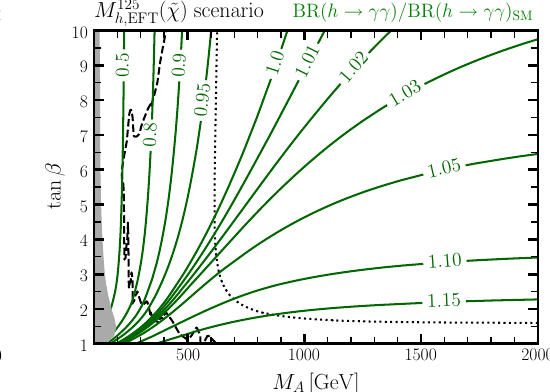
tour lines ). In each plot, the gray exclusion region and the boundaries ( ˜ χ) sce- of the blue and the hatched exclusion regions (shown as dashed and h , EFT dotted black lines , respectively) of Fig.4 are also